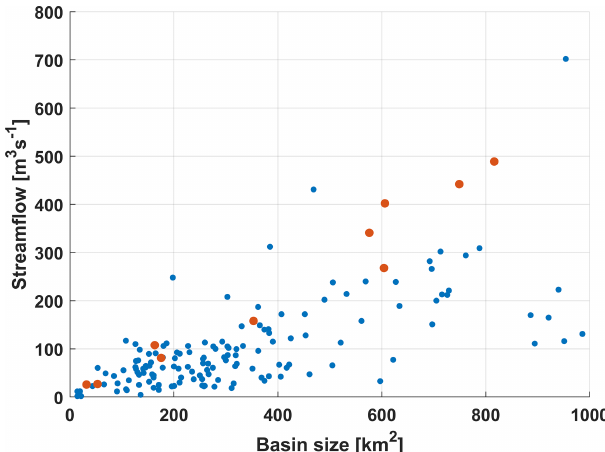
Figure 6. Relation between basin size and daily mean streamflow for the 124 gauges in the CReg region (GRDC data set; blue dots) and the estimated maximum values of the 2021 flood event at 10 gauges in the LReg area (2021GD; red dots). For GRDC, the max- imum daily mean streamflow for each gauge in the data set is used (see also Table 1). The location of the 2021GD stations is shown in Part 1, Fig. 1, and additional information is given in Part 1, Table